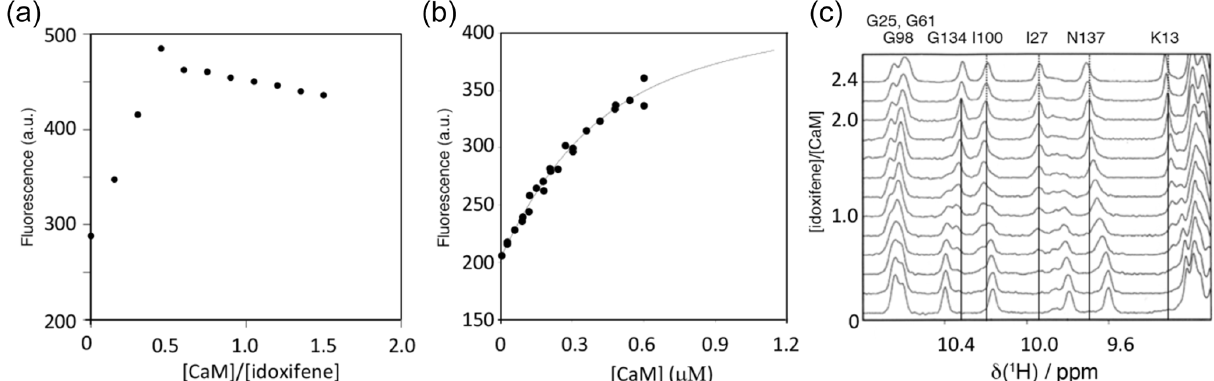
Figure 2. Titration of idoxifene with calmodulin. (a) The changes in fluorescence intensity of 10µM idoxifene at 450nm on addition of CaM up to 15µM. Saturation is reached at a concentration ratio of CaM to idoxifene of 0.5, indicating the presence of two binding sites with sub- micromolar binding affinity. (b) Repeat of (a) but with 0.54µM idoxifene and increasing CaM concentrations from 0.02µM up to 0.6µM. The data were fitted to a binding isotherm with a 2 : 1 idoxifene : CaM binding stoichiometry. (c) A region of the 1D 1 H spectra acquired during the titration of idoxifene into 3mMCaM. Solid lines highlight the completion of the slow exchange event for the assigned resonances at 2 : 1 idoxifene : CaM. Dotted lines are drawn for resonances undergoing shift changes beyond the end point of the titration. G134, I100, and I27 are representative of the slow exchange regime observed for CaM resonances during the titration, while N137 is representative of an intermediate exchange character.